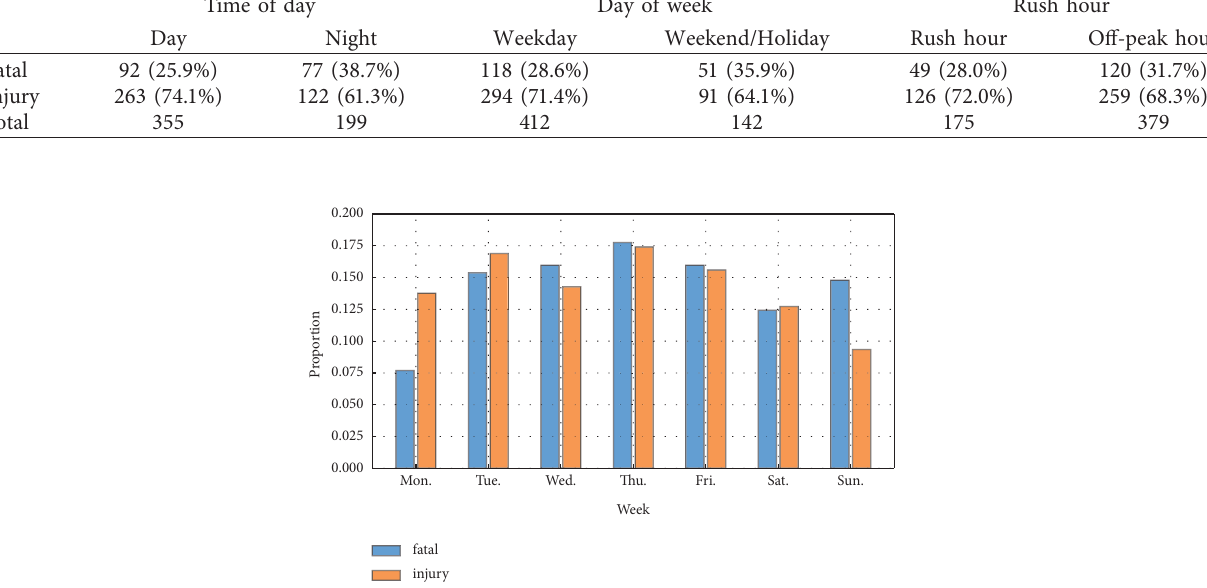
Figure 3: The variation tendency of crashes counted by different days of the week.